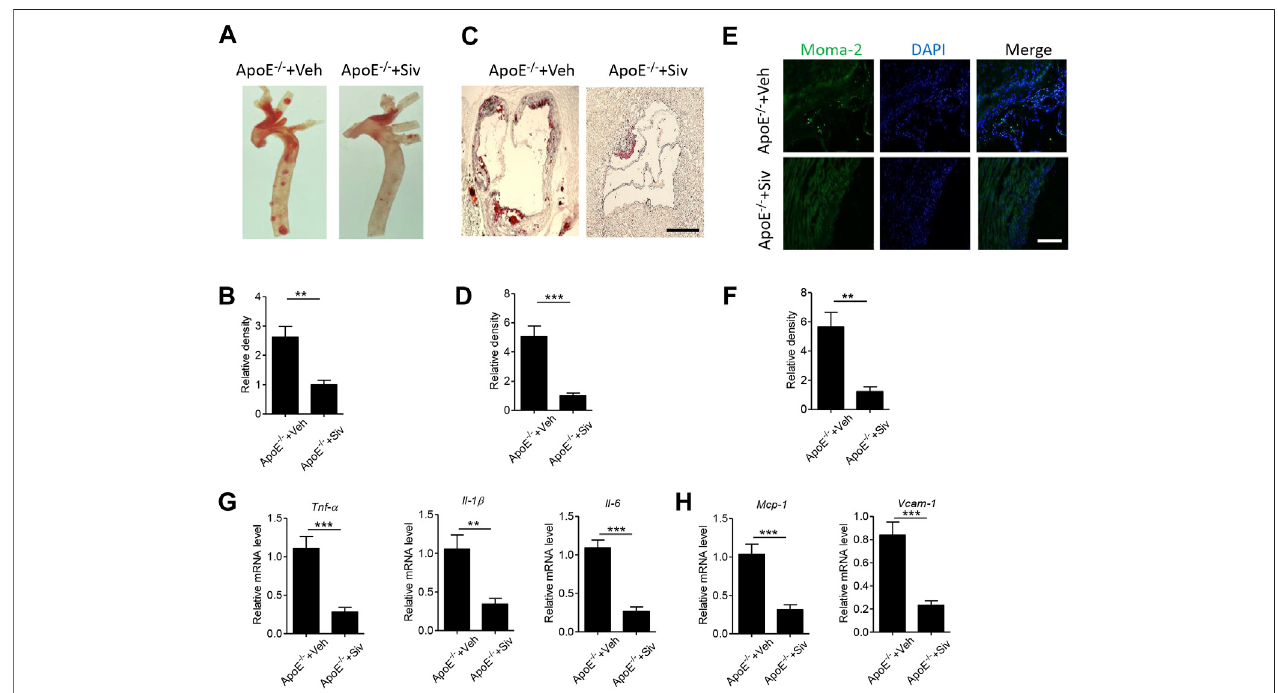
FIGURE 2 | Sivelestat attenuates HFHC-induced atherosclerotic plaque formation and vascular in fl ammation in Apo E -/- mice. Male Apo E -/- mice were fed with HFHC diet for 4 weeks and then treated with sivelestat (Siv, 50 mg/kg per day, intraperitoneal injection) or phosphate-buffered saline (Veh) for 8 weeks. (A-B) Oil Red O stainingoftheenfaceaorta (A) andquantitativeanalysisoftherelativelipiddensity (B) . (C-D) OilredOstainingoftheaortaroot (C) andquantitativeanalysisoftherelative lipid density (D) . Scale bar = 200 μ m. (E-F) Immuno fl uorescence staining of aorta root sections with anti-moma-2 antibody (E) and quantitative analysis of the relative density (F) . Scale bar = 100 μ m. (G-H) Real-time PCR analysis of gene levels of in fl ammatory cytokines (G) , including Tnf- α , Il-1 β , and Il-6 , and chemokines (H) including Mcp-1 and Vcam-1 . Data are shown as mean ± SEM. n = 6 mice/group, and ** p < 0.01 and *** p <